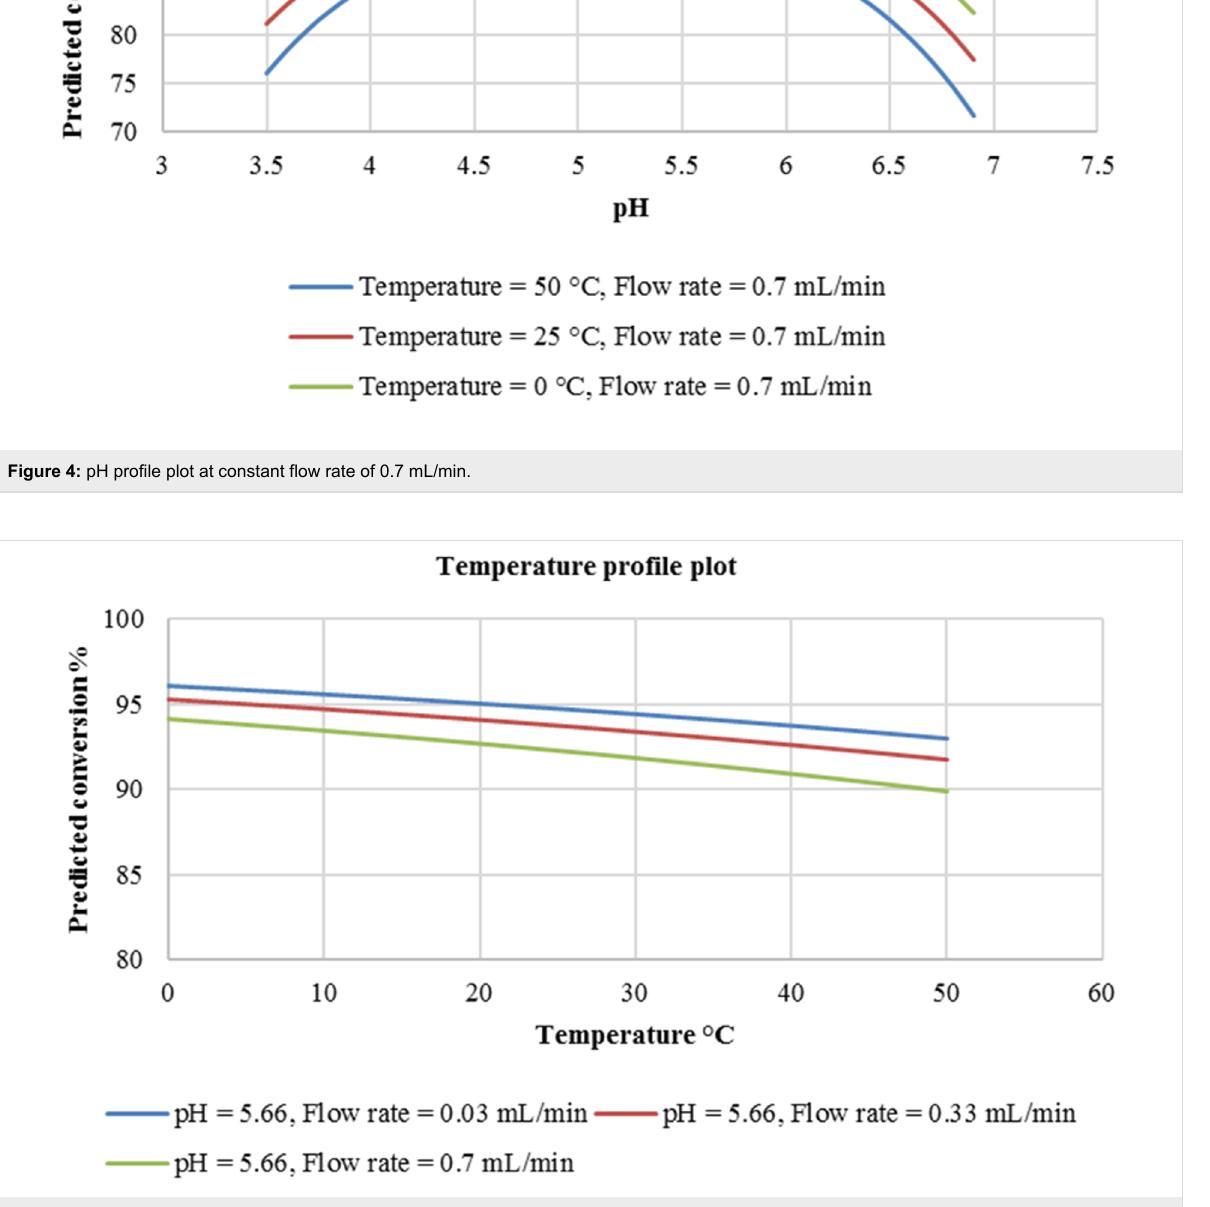
onto the observed data and no outliers were found during this model fitting procedure in addition, there were also no indica- tions of either synergistic or antagonist interactions between the